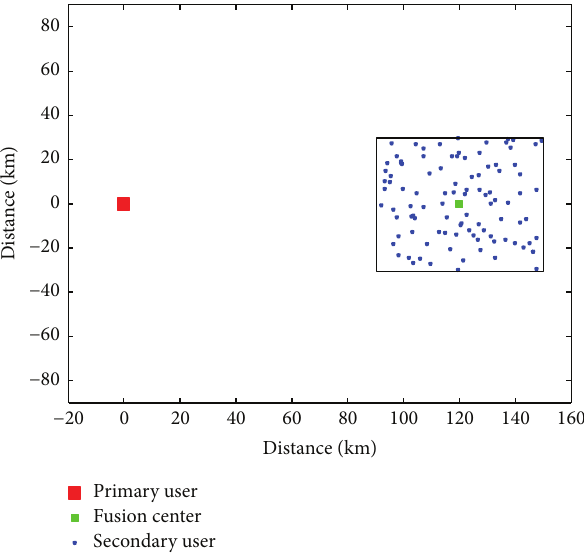
Figure 3: Simulation scenario for cooperative cognitive network with 100 secondary users, primary user, and fusion